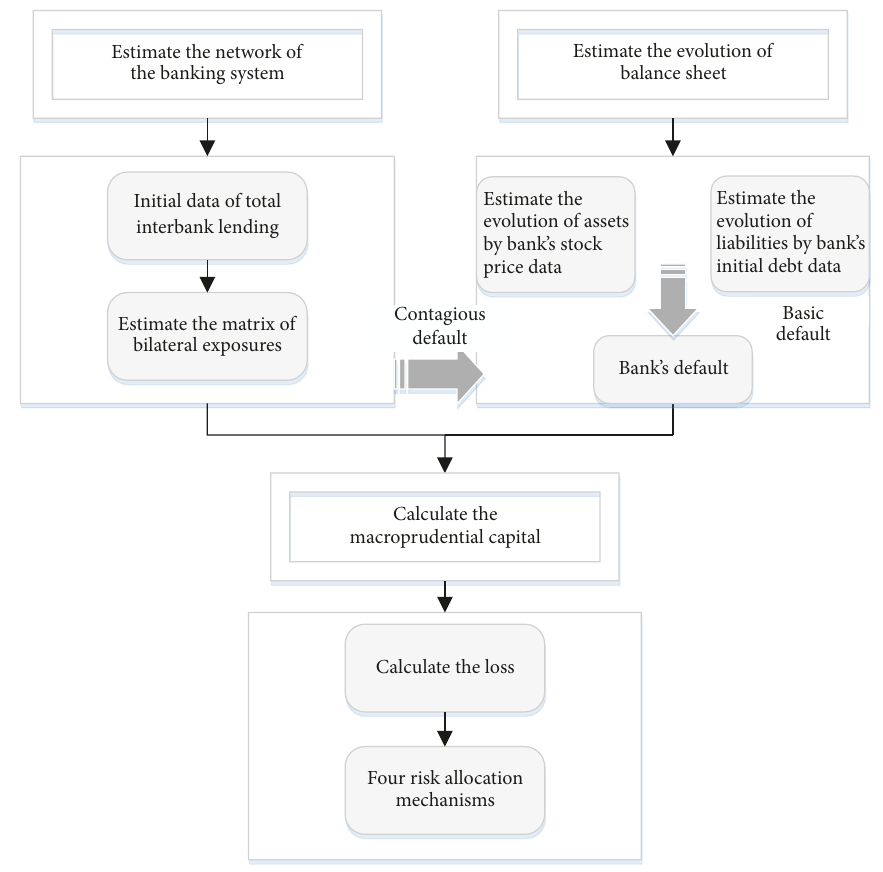
Figure 1: The theoretical